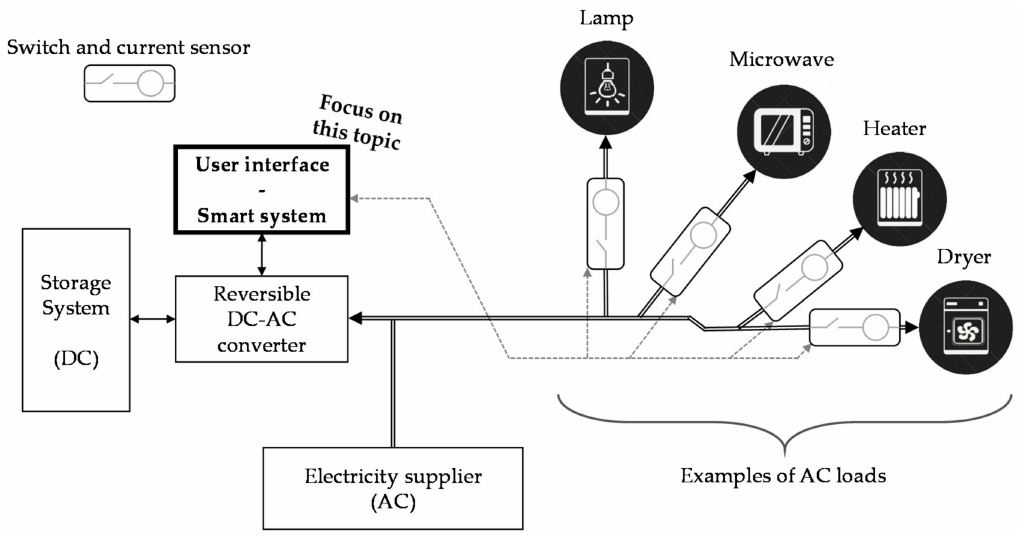
Figure 1. Simplified illustration of the proposed smart